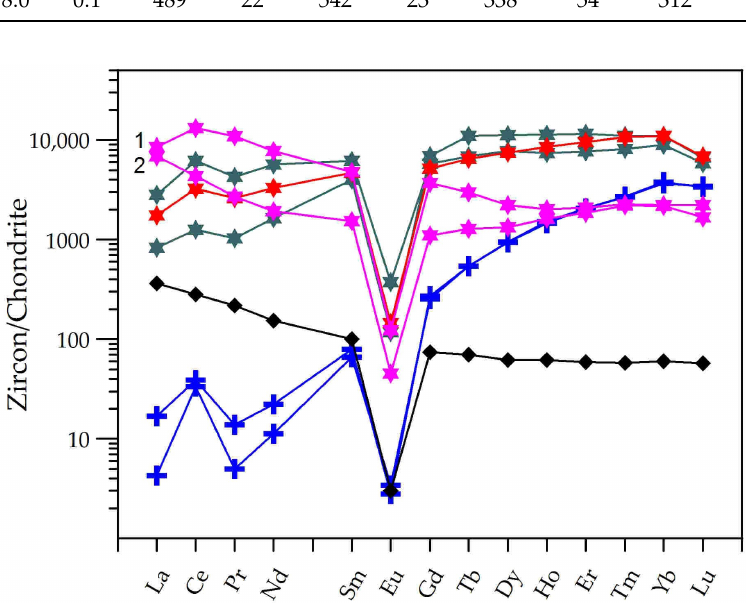
Figure 7. REE patterns for the primary and hydrothermal zircon and the CO-2A host granite, normalized to the chondritic values of Boynton [50]. Symbols: black diamond—host rock; others as in Figure